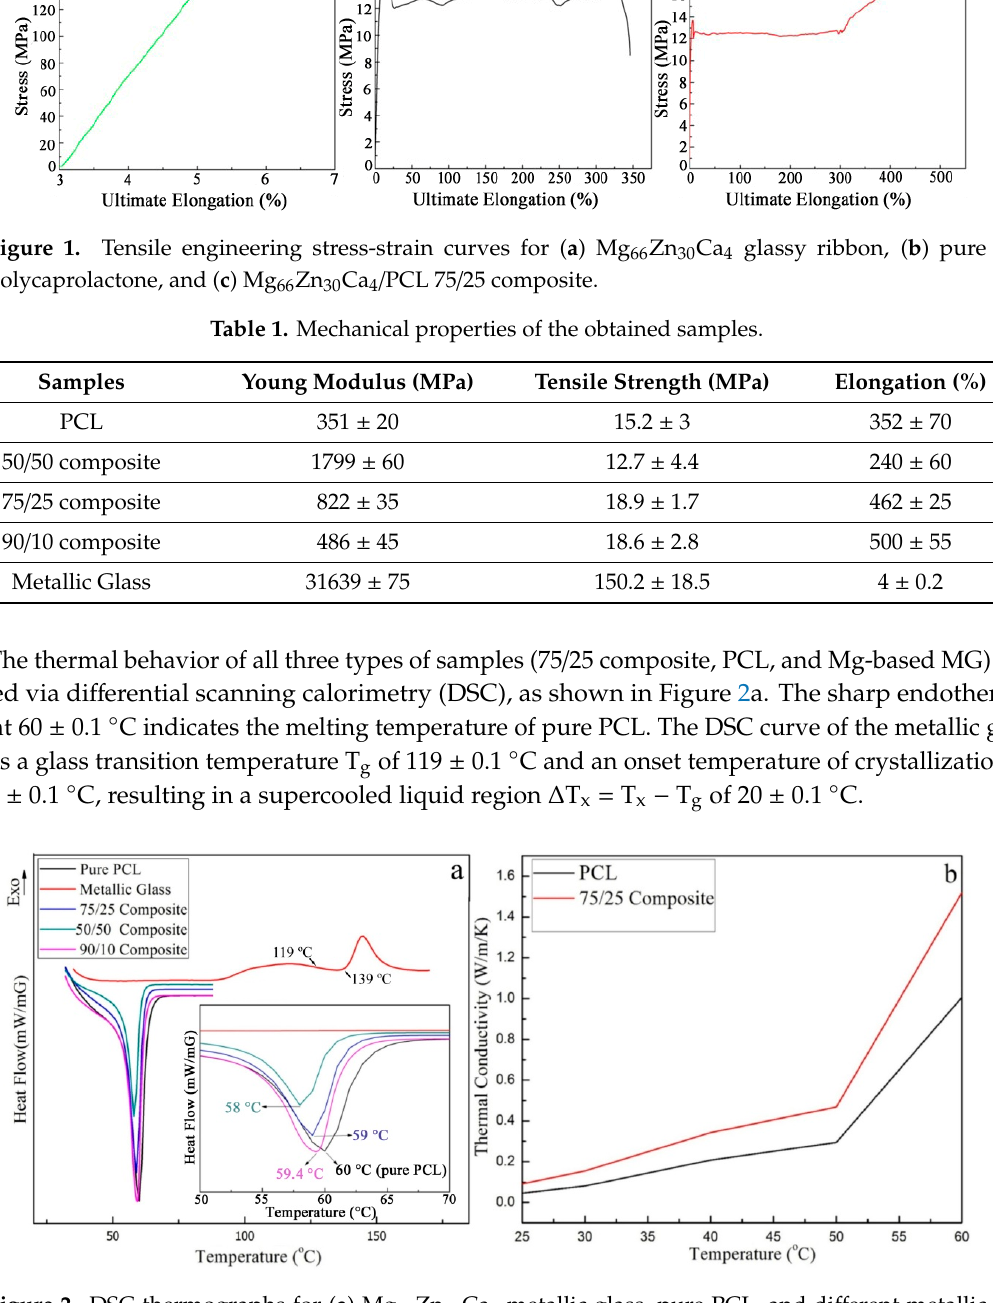
Figure 2. DSC thermographs for ( a ) Mg 66 Zn 30 Ca 4 metallic glass, pure PCL, and different metallic glass / PCL composites; ( b ) thermal conductivity of the pure PCL and 75 / 25 composite